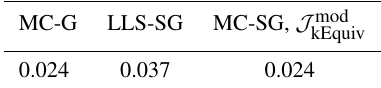
Table 3. Root-mean-square error of the analytical models against the LES results from Porté-Agel et al.